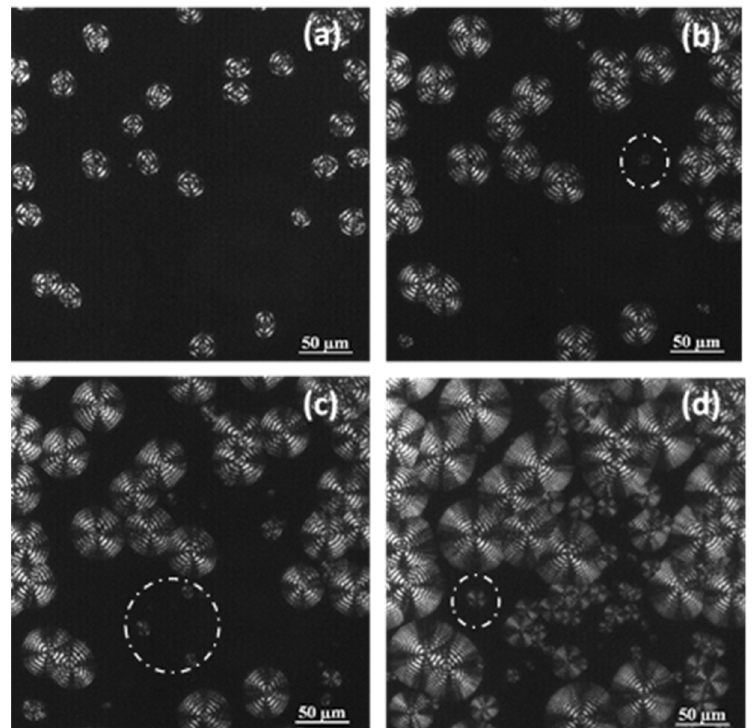
Figure 4. Optical micrographs of P4HB spherulites formed at the indicated non-isothermal crystallization times by cooling the sample at a rate of 0.5 ◦ C / min from 45 ◦ C, where some spherulites were isothermally grown (60 min) from the melt state. Micrographs were taken at temperatures of 44 ◦ C ( a ), 38 ◦ C ( b ), 36 ◦ C ( c ), and 33 ◦ C ( d ).